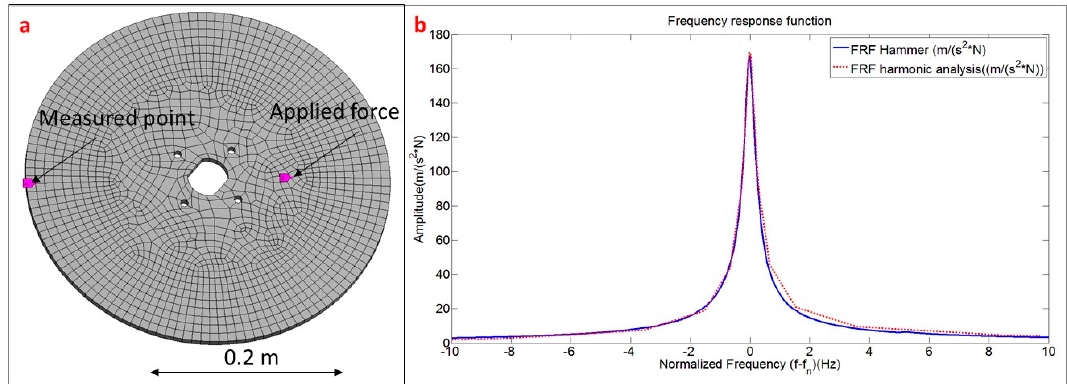
Figure 12. ( a ) Simulation model including the position of the force and the measurement point; and ( b ) application of the harmonic response compared to experimental result for the 3rd mode.